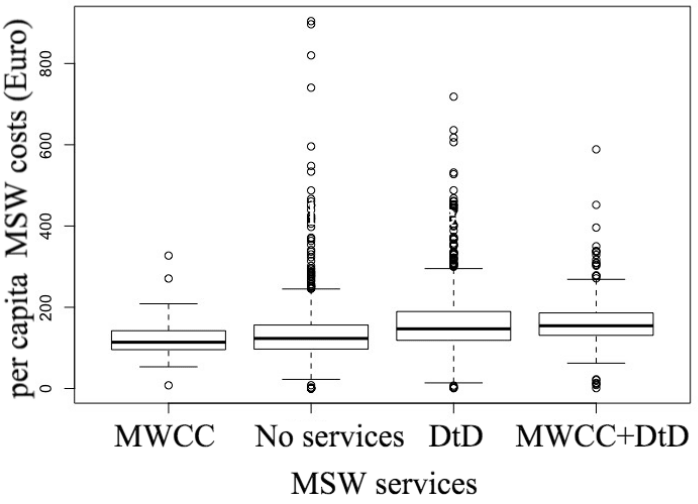
Figure 13. Boxplot of waste collection and disposal costs in comparison with the provision of door-to-door service or municipal waste collection